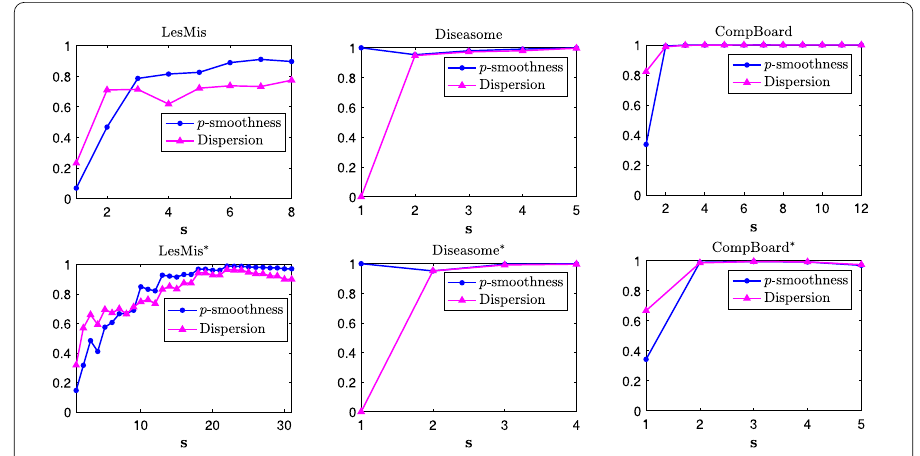
Figure 4 The p -smoothness and dispersion values of the s -connected components for LesMis, Diseasome, and CompBoard (top row) and their dual hypergraphs (bottom row)